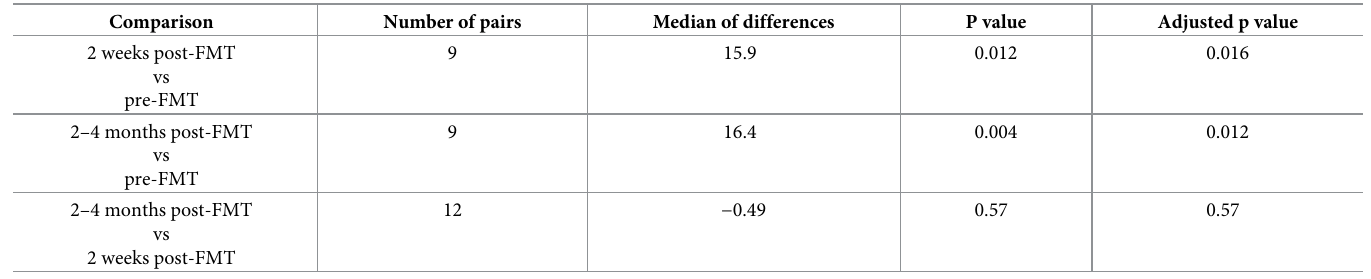
Table 2. Results of the Wilcoxon matched-pairs signed-rank